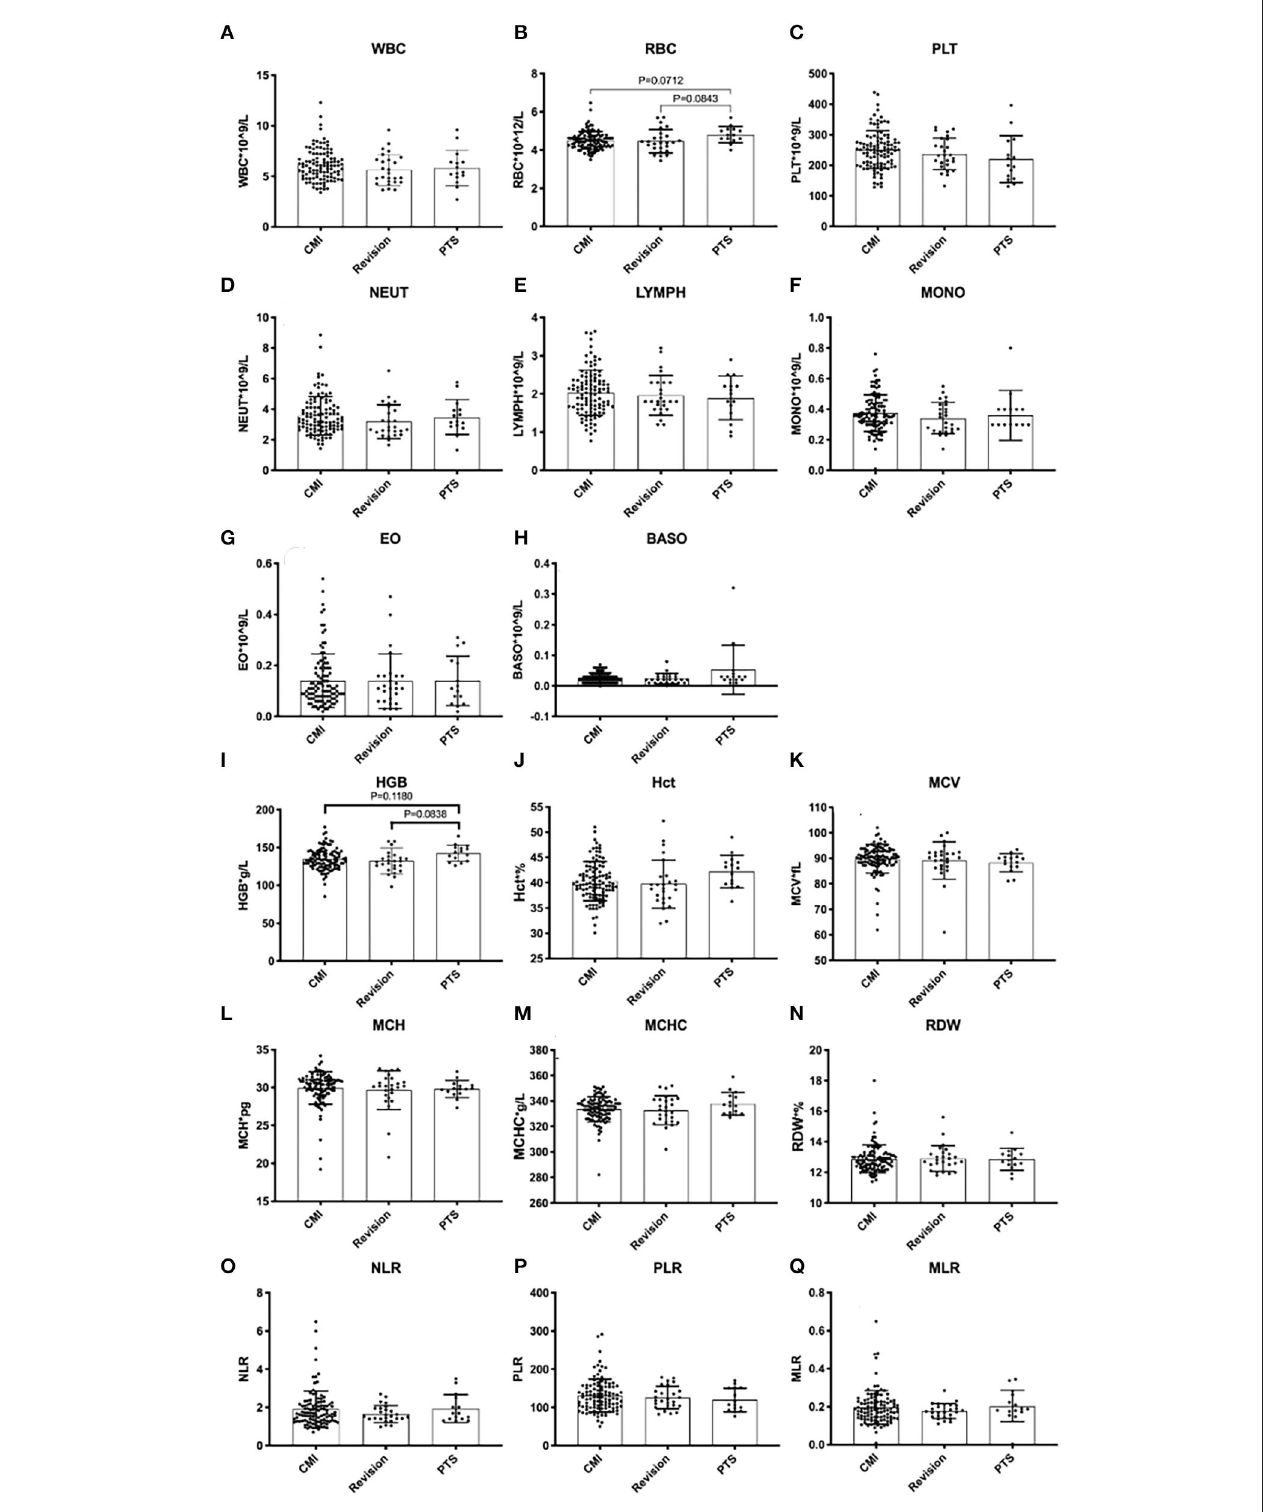
FIGURE 4 | Peripheral blood inflammatory markers in syringomyelia of different etiologies.